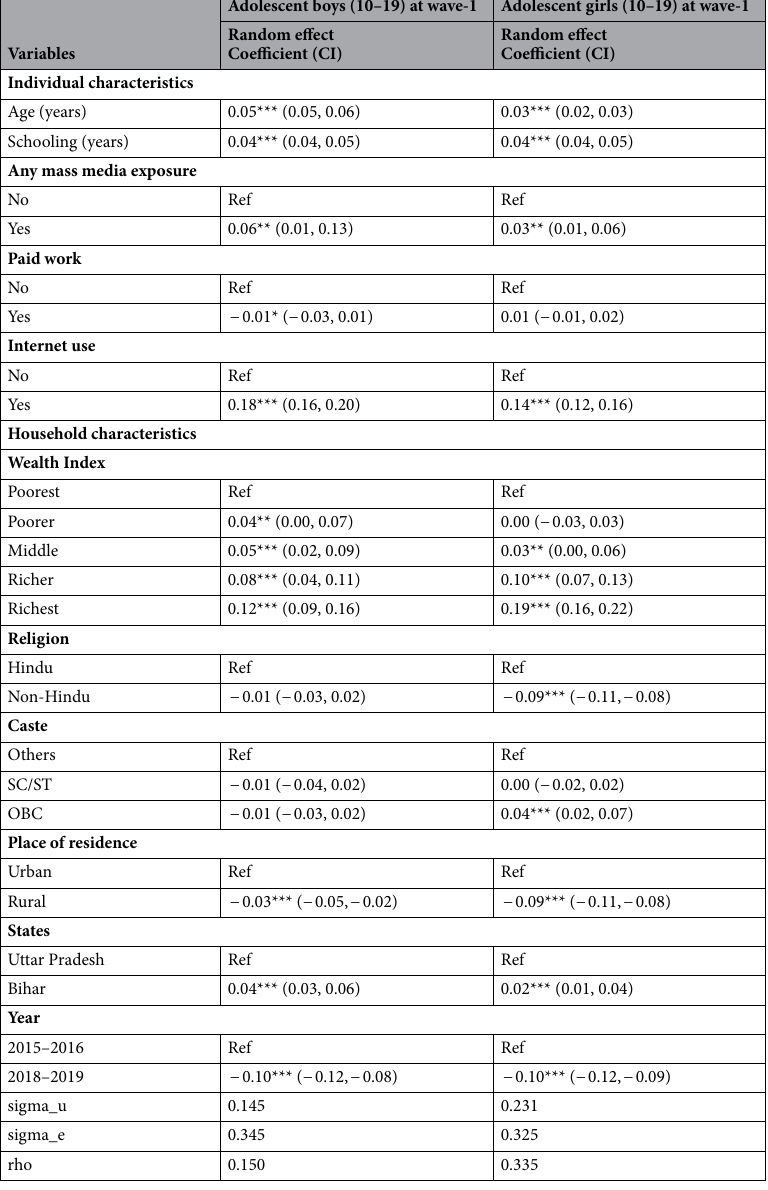
Table 3. Estimated effects of explanatory variables on the awareness of HIV from random effect models. **if p < 0.05 ***if p < 0.001; Ref Reference; CI confidence interval; SC/ST Scheduled Caste/Scheduled Tribe; OBC: Other Backward